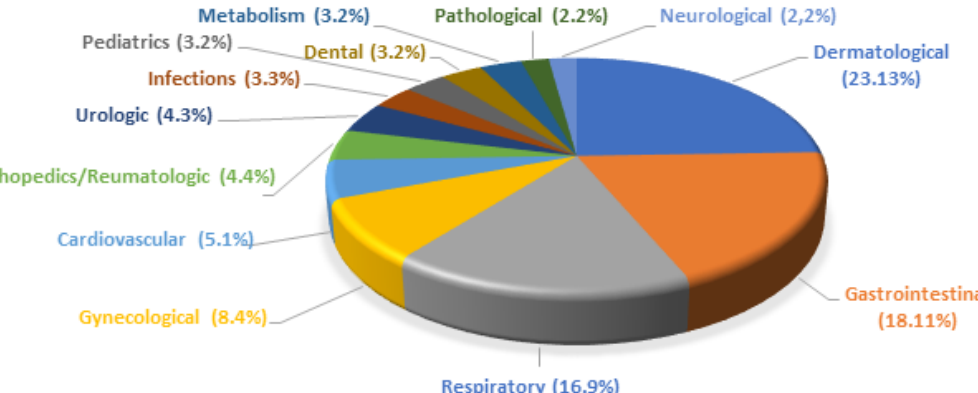
Figure 1. Distribution of native and cultivated plant taxa mentioned in interviews by disease type.